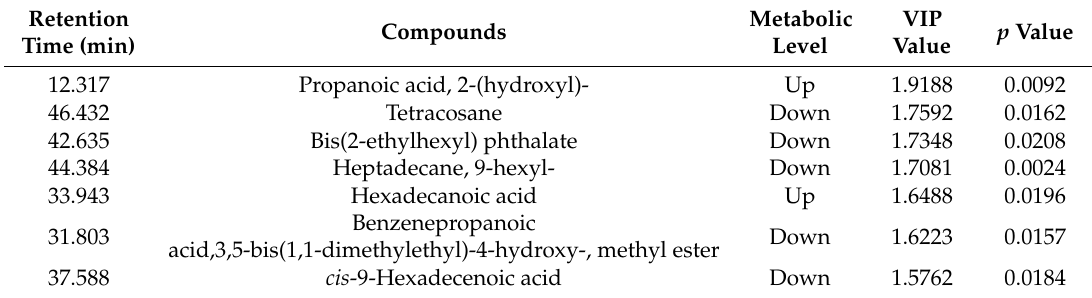
Table 2. The differently abundant metabolites from HN66 root tissue under different continuous- cropped year soil in